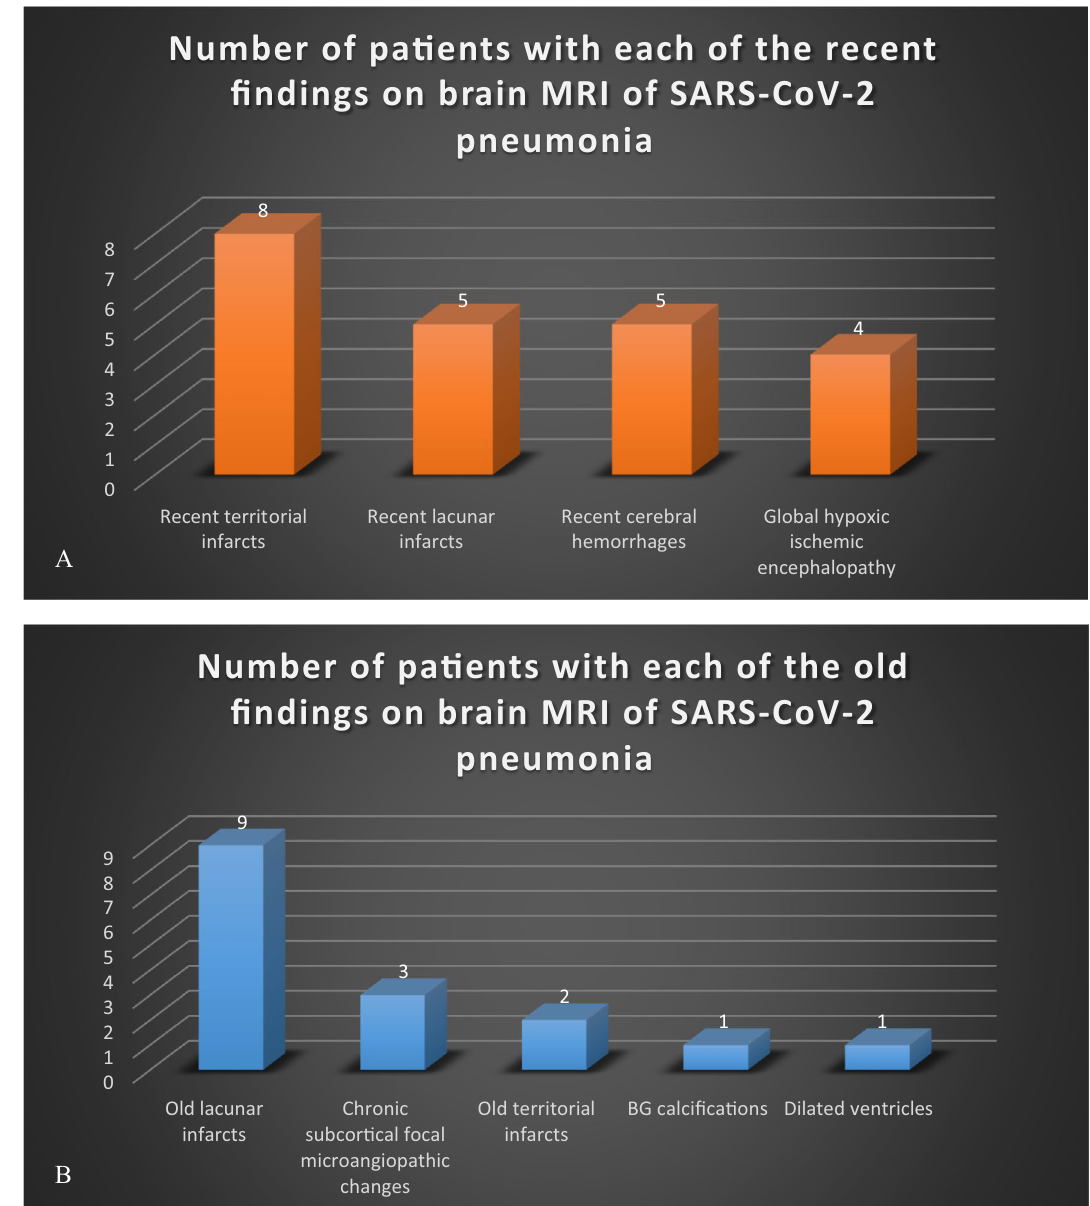
Figure 2. Frequency of patients with recent ( A ) and old ( B ) diagnostic findings on positive brain MRI of 38 among 46 patients with RT-PCR confirmed SARS-CoV-2 pneumonia and presented with neurological